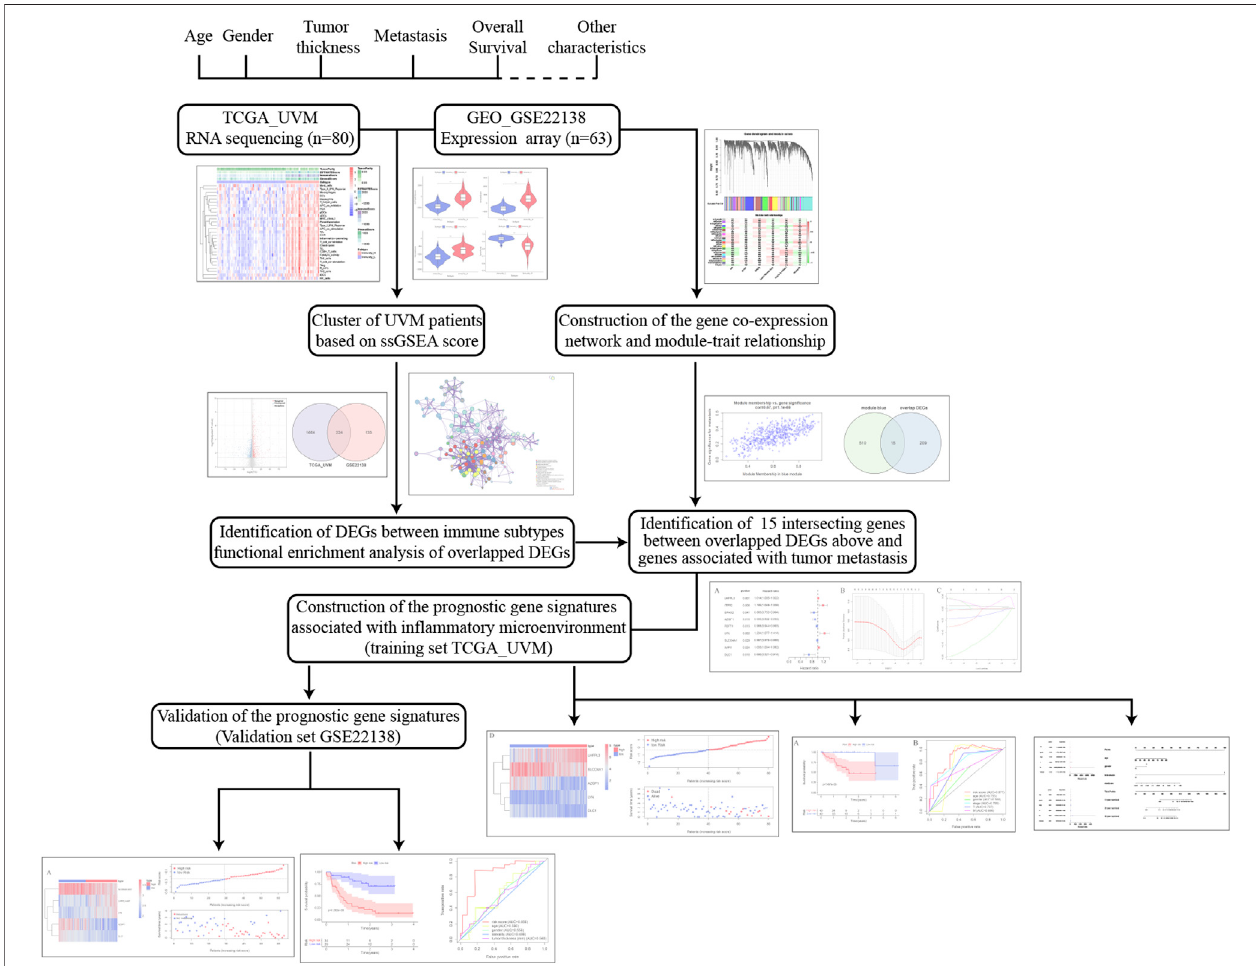
FIGURE 1 | The work fl ow of the analysis in this